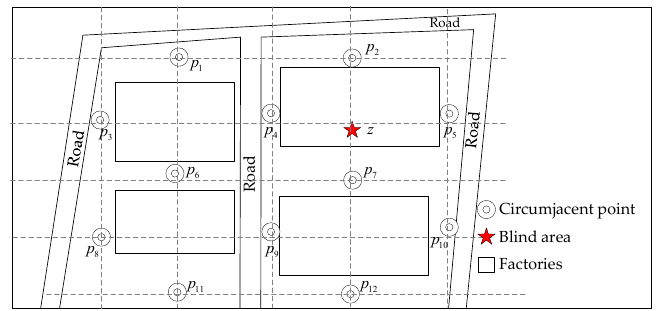
Figure 1. Layout of monitoring points and blind area.